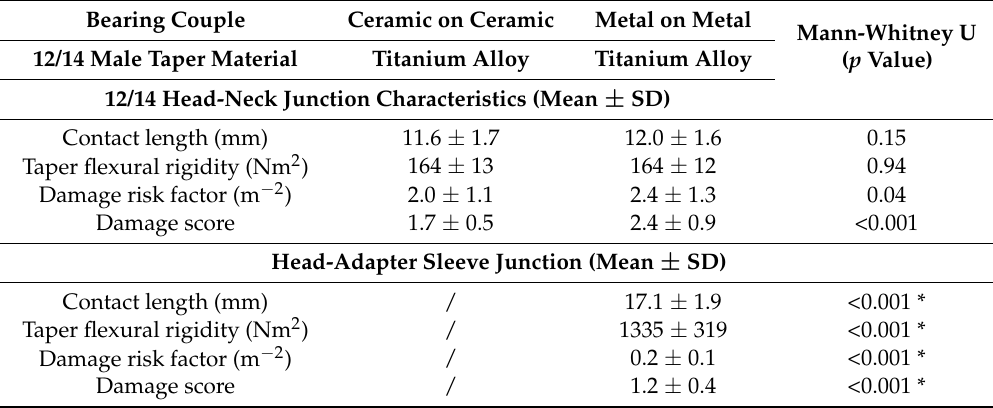
Bearing Couple Ceramic on Ceramic Metal on Metal